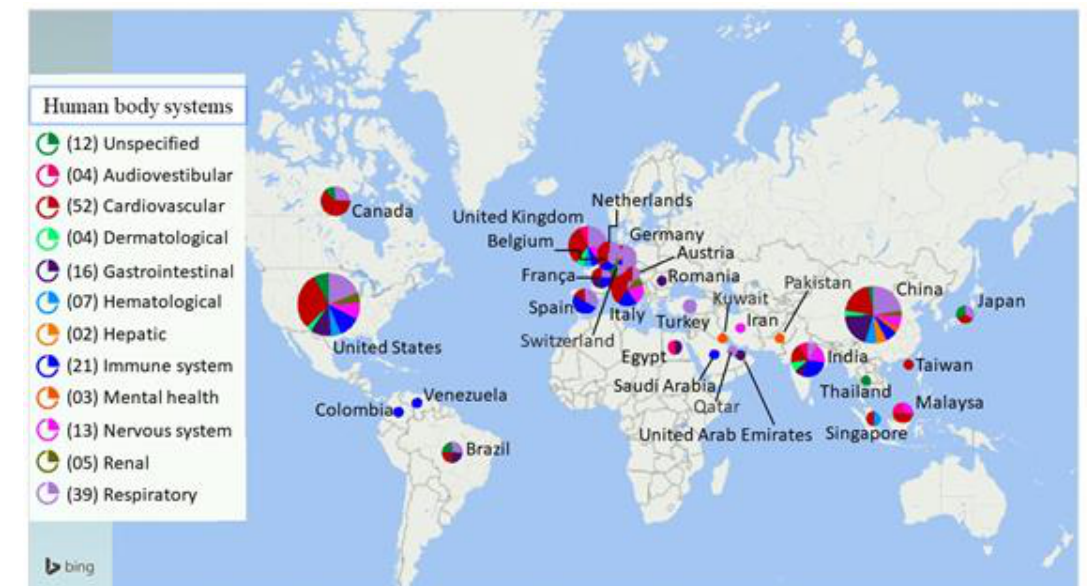
Figure 1. Geographical distribution of the studies used in this review and the number of articles reviewed per human body system. The map shows the countries where the articles were produced, as well as their respective approaches to human body systems affected by post- and long-term health complications associated with COVID-19.